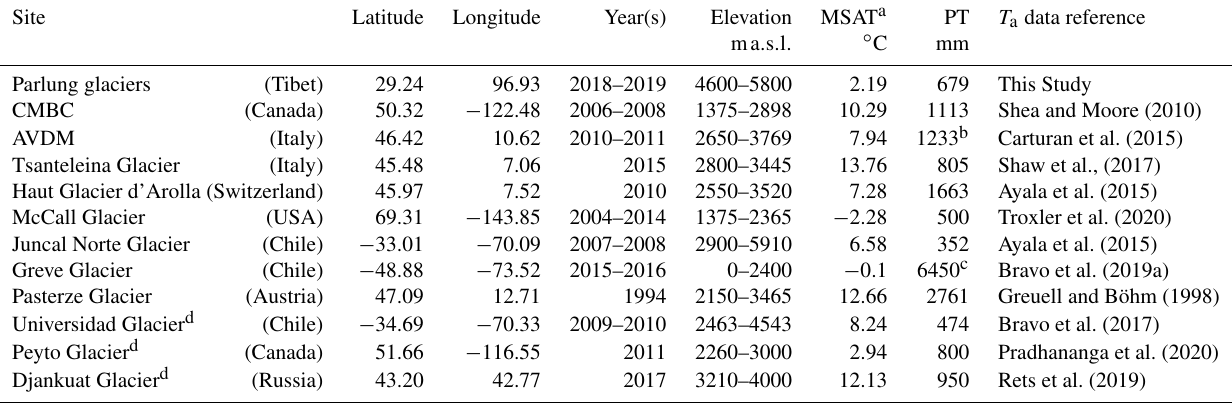
Table 2. The details of each site where distributed on-glacier air temperatures are available. Elevation ranges and ERA5 mean summer air temperatures (MSATs) are reported for the year of investigation. Precipitation totals (PT, mm) were obtained from the cited literature. Site